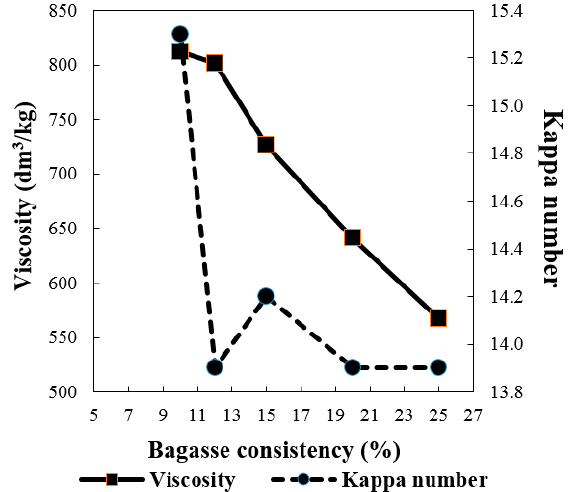
Figure 6. Effect of bagasse consistency on viscosity and Kappa number (same cooking conditions with Figure 5).